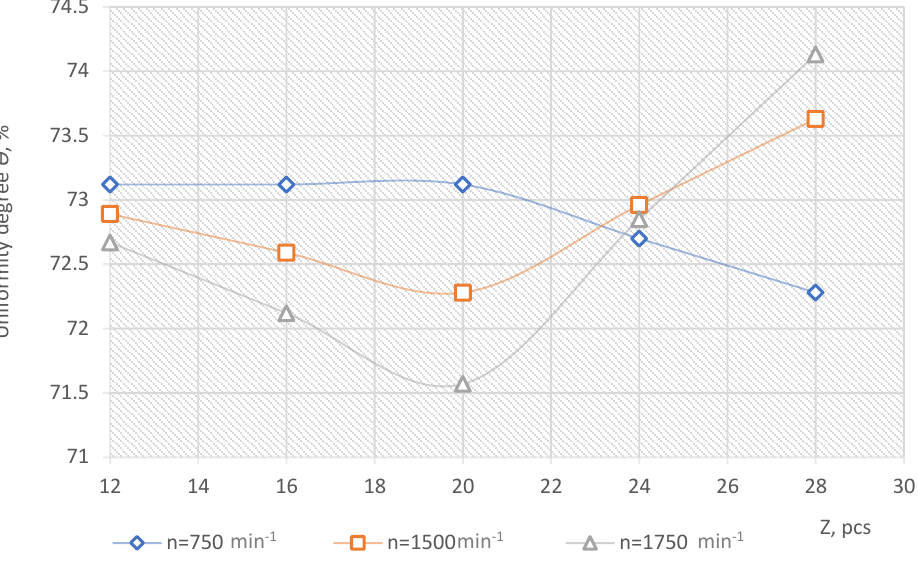
Figure 8. Dependence of the degree of homogeneity Θ ,% on the number of stationary blades Z, pcs, Figure 8 . Dependence of the degree of homogeneity Ѳ,% on the number of stationary blades Z, at different speeds at angles β 2 = 90 ◦ and β st = 90 ◦ pcs, at different speeds at angles β2 = 90 ° and βst = 90 °.